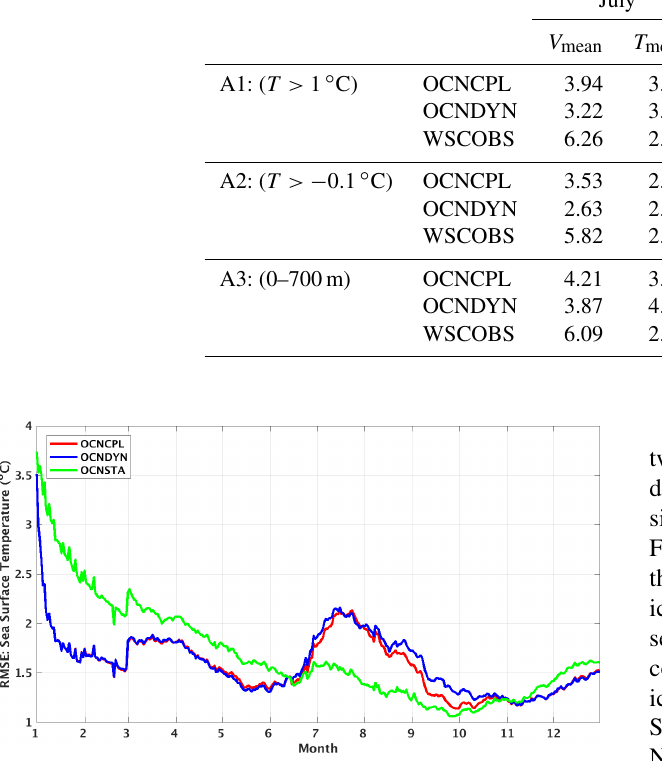
Figure 13. Time series of the RMSE of modeled SST with respect to the GMPE observations in 2012. The red, blue and green lines denote the SST RMSE of the OCNCPL run, the OCNDYN run and the OCNSTA run, respectively. GMPE: Group for High-Resolution Sea Surface Temperature Multi-Product